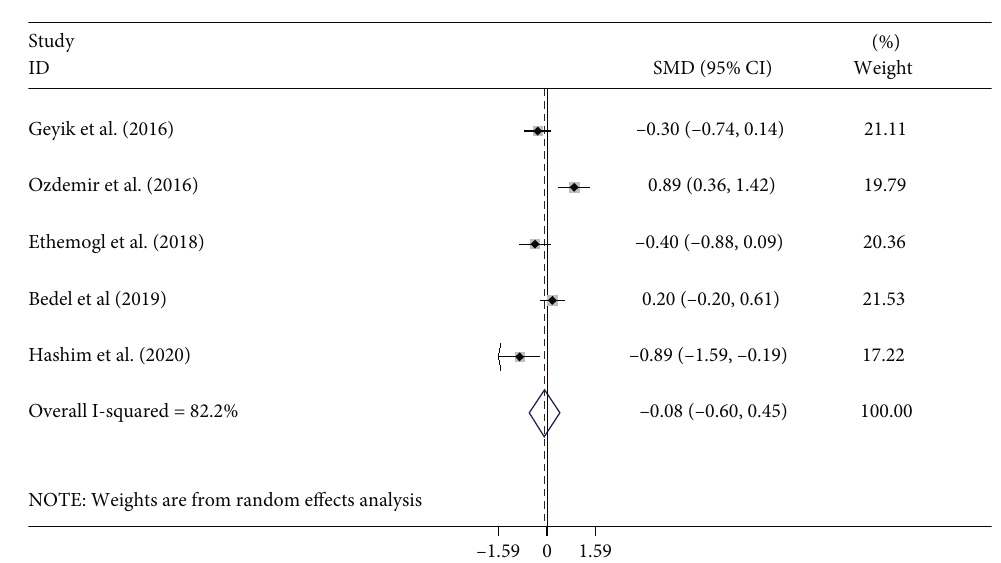
Figure 10: Meta-analysis of di ff erences in NLR levels between patients with AIDP and axonal